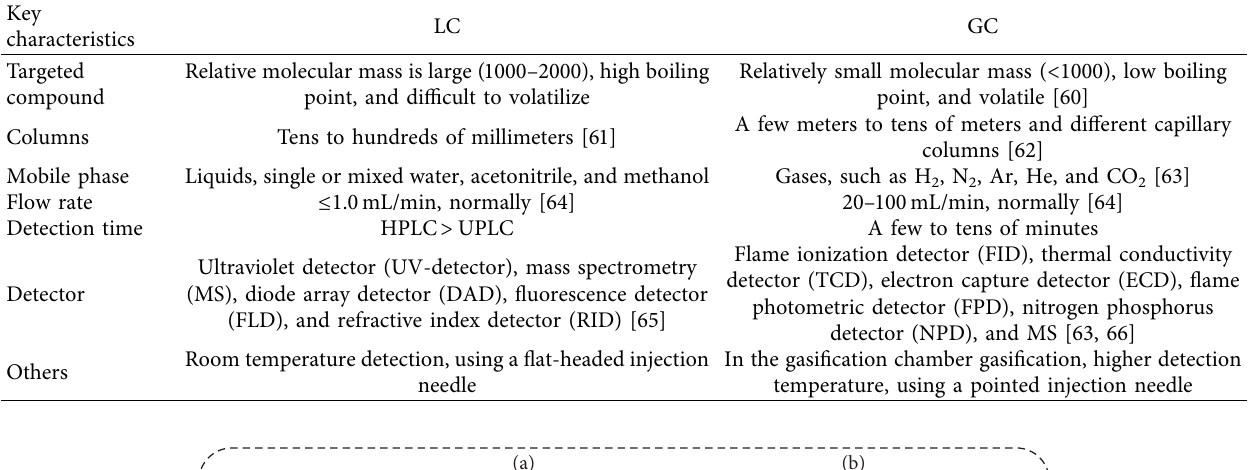
Table 2: Key parameters in liquid and gas chromatography.